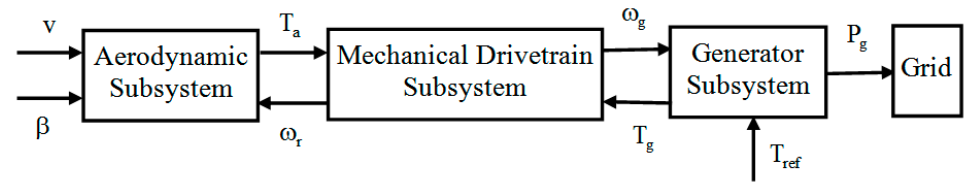
Figure 1. The WT